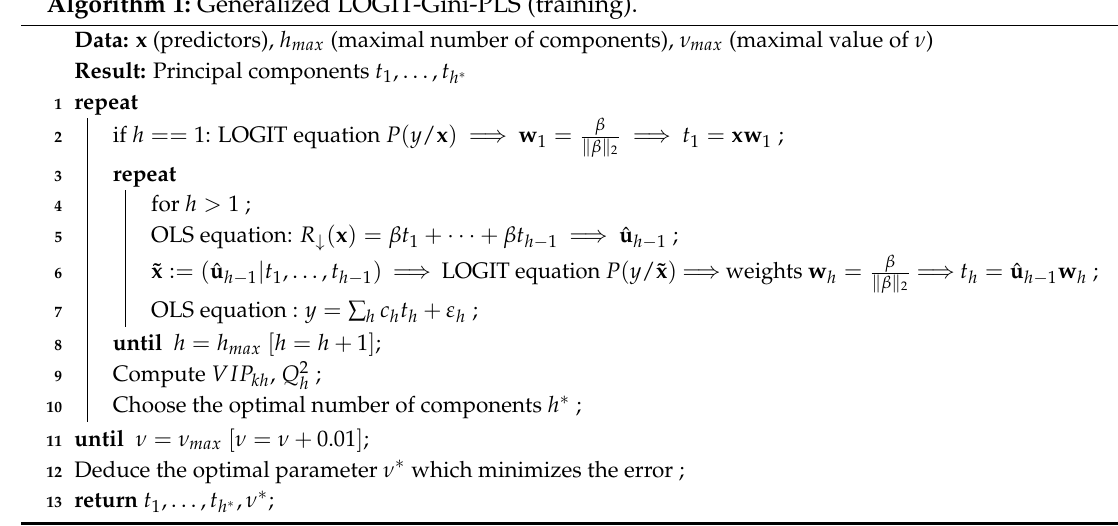
Algorithm 1: Generalized LOGIT-Gini-PLS